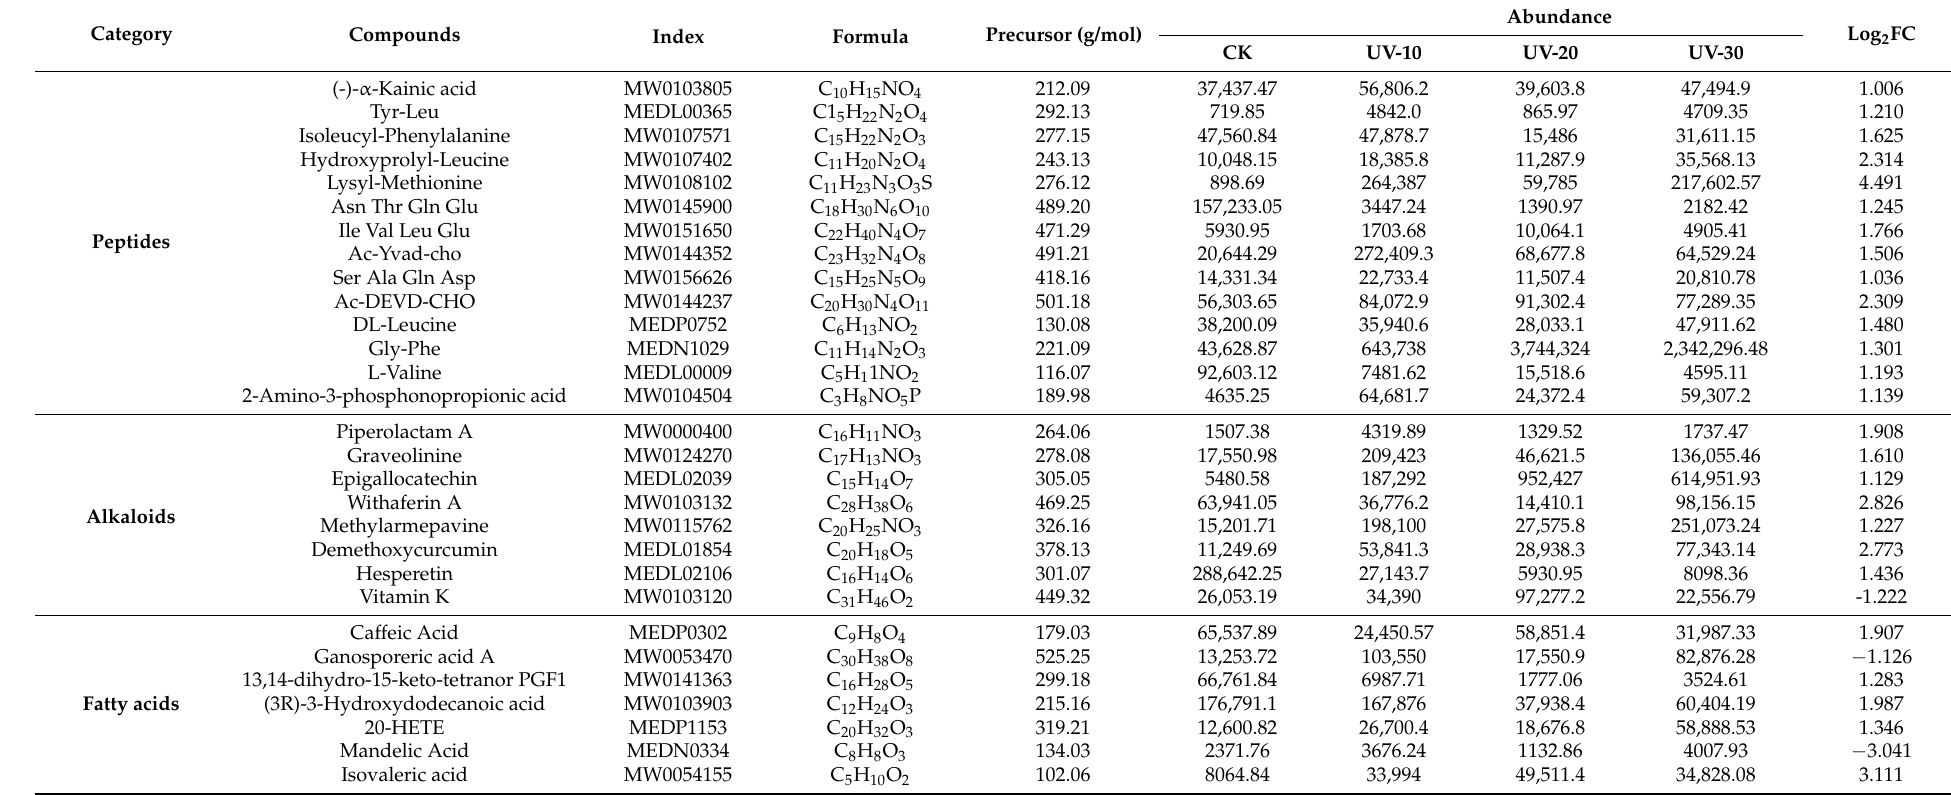
Table 1. Bioactive compounds screened from the significant components from different UV-induced treatments of